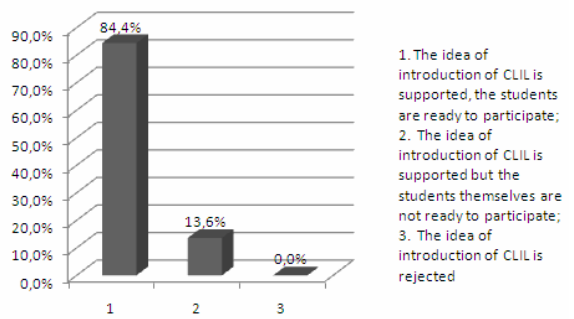
Figure 5. The results of student enquiry in the introduction of CLIL at the Latvia University of Agriculture